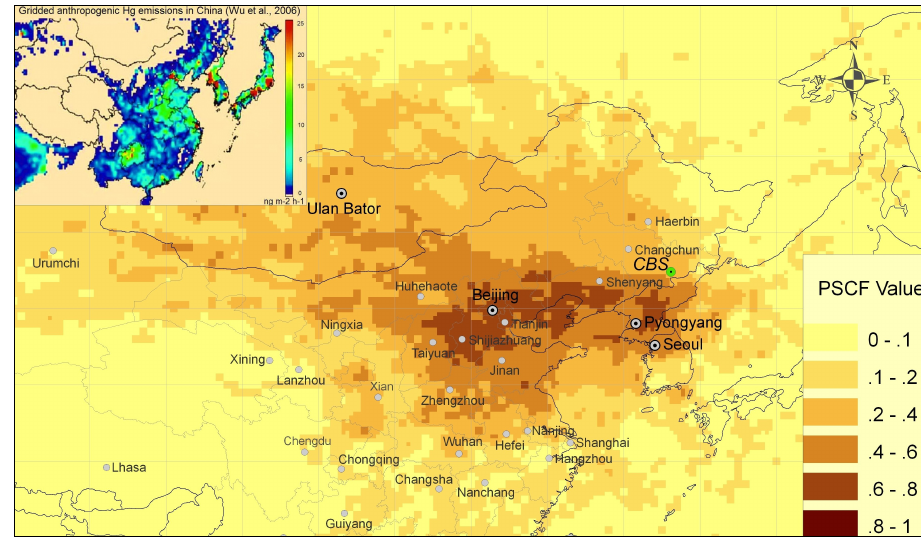
Fig. 4. Likely potential source areas of TGM identified by PSCF analysis at CBS for the whole study period.